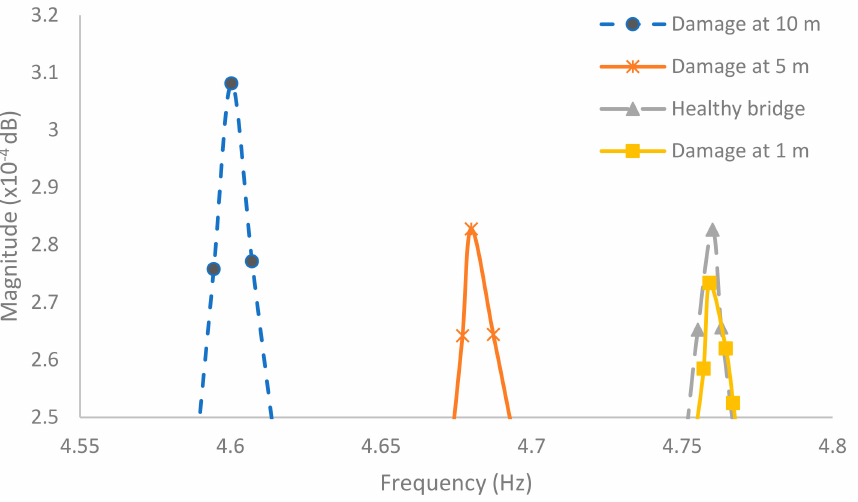
Figure 5. Fast Fourier transform results in different damage